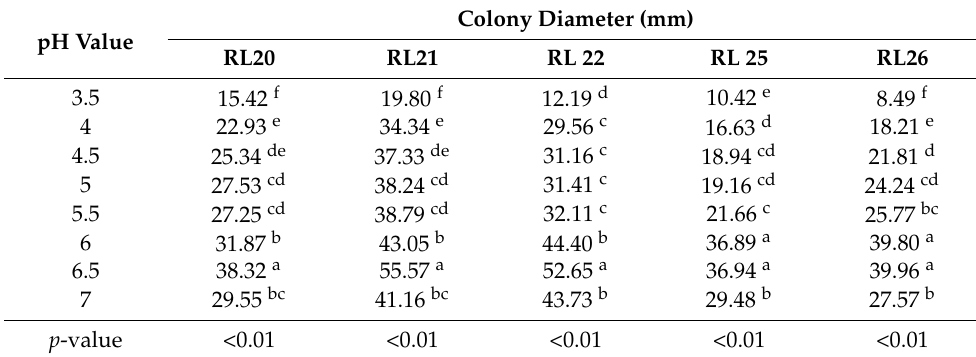
Table 5. Average colony diameters of all five isolates of R. microporus after 3 days of incubation under different